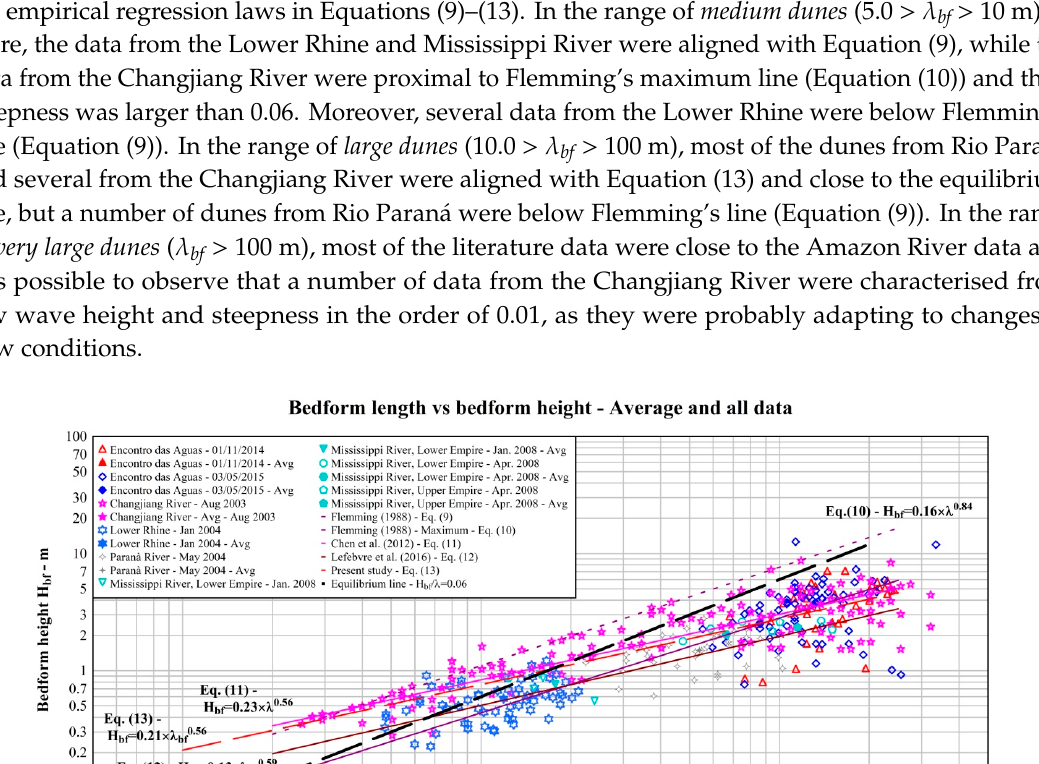
Table 10. Main parameters of bedforms from the literature data sets. Legend: λ bf-mean = mean of the